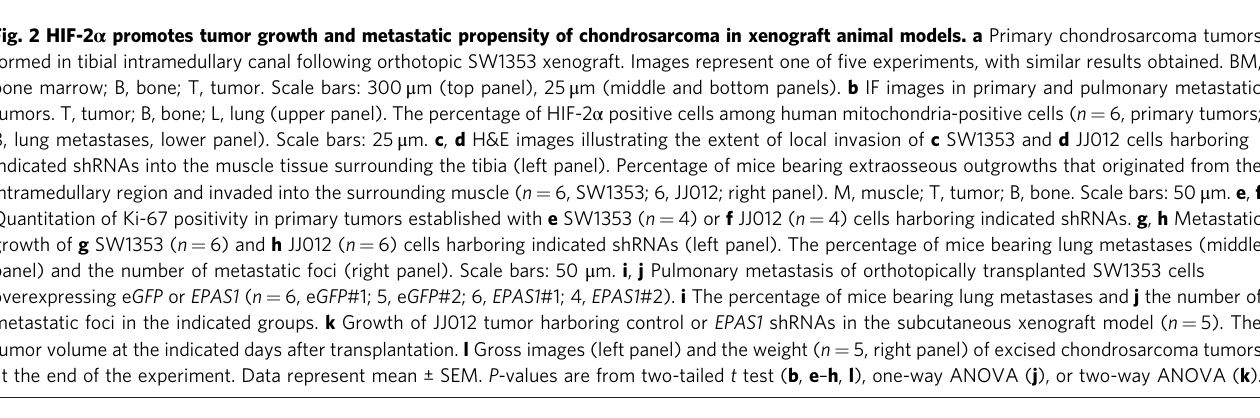
Fig. 2 HIF-2 α promotes tumor growth and metastatic propensity of chondrosarcoma in xenograft animal models. a Primary chondrosarcoma tumors formed in tibial intramedullary canal following orthotopic SW1353 xenograft. Images represent one of fi ve experiments, with similar results obtained. BM, bone marrow; B, bone; T, tumor. Scale bars: 300 μ m (top panel), 25 μ m (middle and bottom panels). b IF images in primary and pulmonary metastatic tumors. T, tumor; B, bone; L, lung (upper panel). The percentage of HIF-2 α positive cells among human mitochondria-positive cells ( n = 6, primary tumors; 8, lung metastases, lower panel). Scale bars: 25 μ m. c , d H&E images illustrating the extent of local invasion of c SW1353 and d JJ012 cells harboring indicated shRNAs into the muscle tissue surrounding the tibia (left panel). Percentage of mice bearing extraosseous outgrowths that originated from the intramedullary region and invaded into the surrounding muscle ( n = 6, SW1353; 6, JJ012; right panel). M, muscle; T, tumor; B, bone. Scale bars: 50 μ m. e , f Quantitation of Ki-67 positivity in primary tumors established with e SW1353 ( n = 4) or f JJ012 ( n = 4) cells harboring indicated shRNAs. g , h Metastatic growth of g SW1353 ( n = 6) and h JJ012 ( n = 6) cells harboring indicated shRNAs (left panel). The percentage of mice bearing lung metastases (middle panel) and the number of metastatic foci (right panel). Scale bars: 50 μ m. i , j Pulmonary metastasis of orthotopically transplanted SW1353